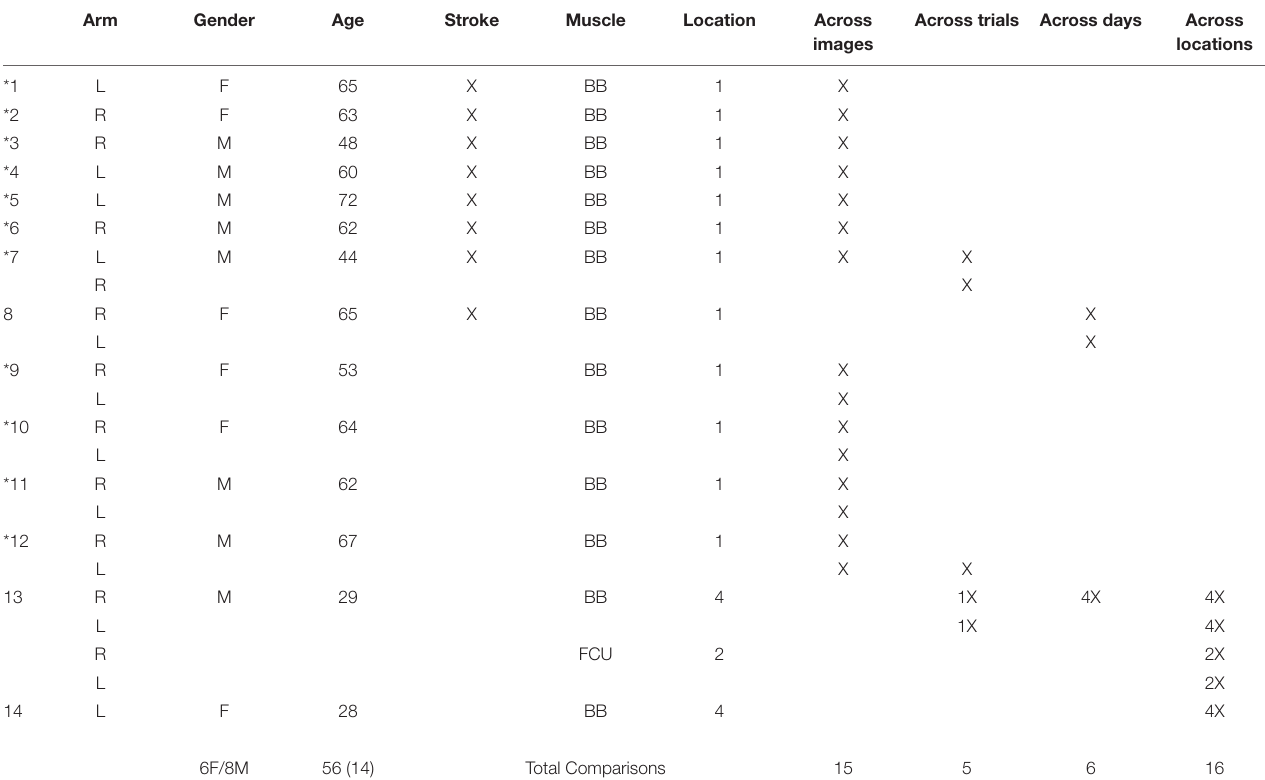
TABLE 1 | Participant demographic and participation information.